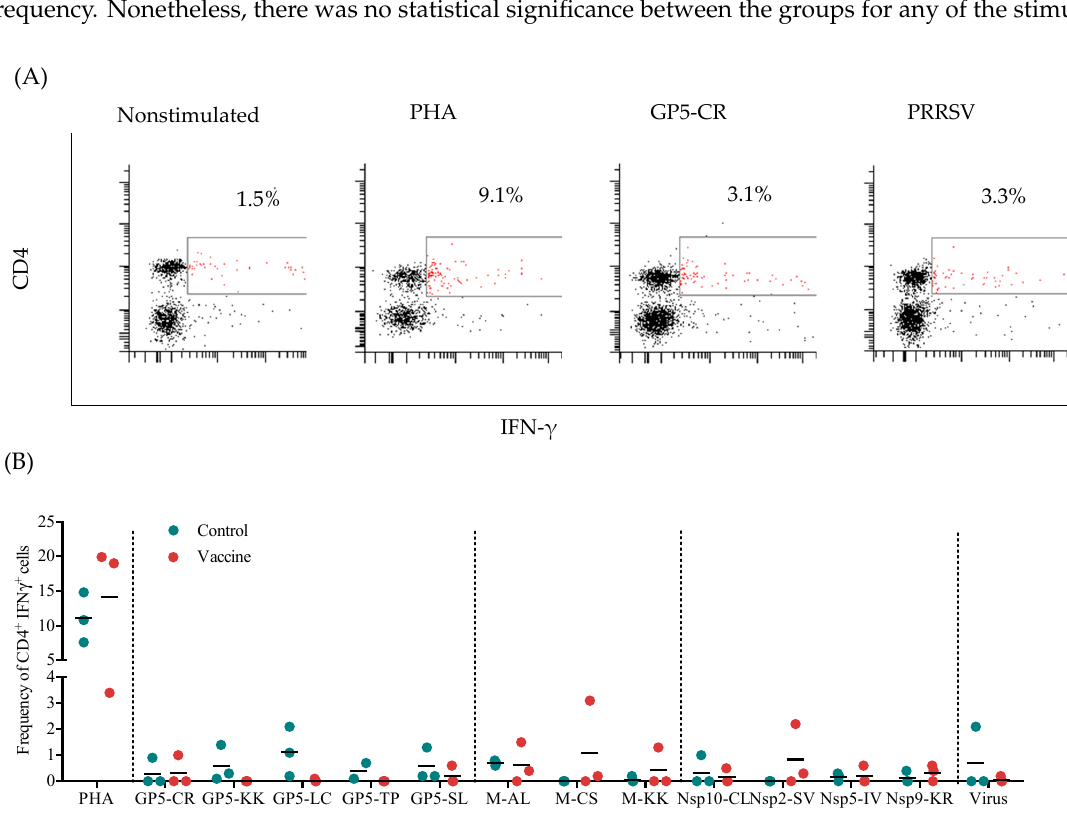
Figure 2. Analysis of CD4 + IFN- γ -secreting cells. ( A ) Representative experiment with PBMCs stimulated with individual porcine reproductive and respiratory syndrome virus (PRRSV) peptides, the whole virus, phytohaemagglutinin (PHA) (positive control) or medium along (unstimulated control). For extracellular labeling, an anti-CD4 antibody conjugated with fluorescein isothiocyanate (FITC) was used, and for intracellular staining, an anti-pig IFN- γ antibody conjugated with phycoerythrin (PE) was used. The selected population corresponded to CD4 + IFN- γ + cells. ( B ) Frequency of CD4 + IFN- γ -secreting cells in immunized pigs. The results were obtained by subtracting the percentage of CD4 + IFN- γ + cells in the unstimulated cell group from the percentage of double-positive cells in the experimental